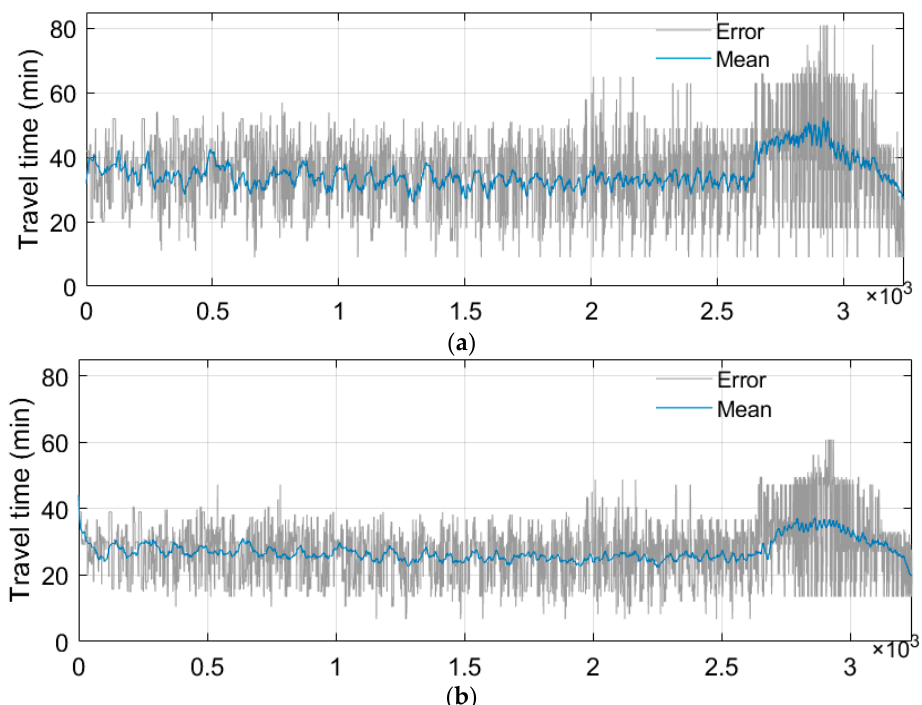
Figure 12. Travel cost comparison ( a ) before and ( b ) after dynamic route